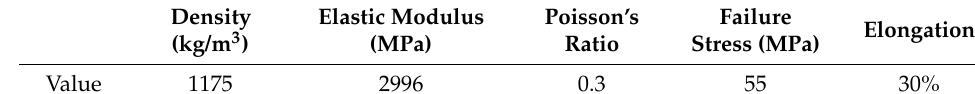
Table 1. Mechanical properties parameters of verowhite.